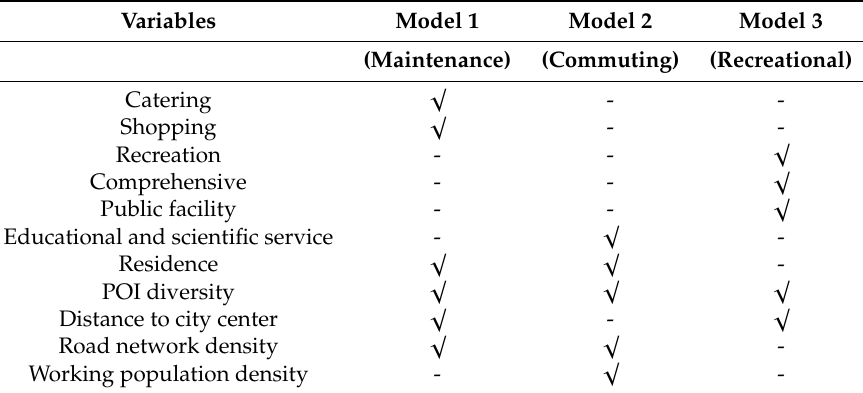
Table 2. Variables in three regression